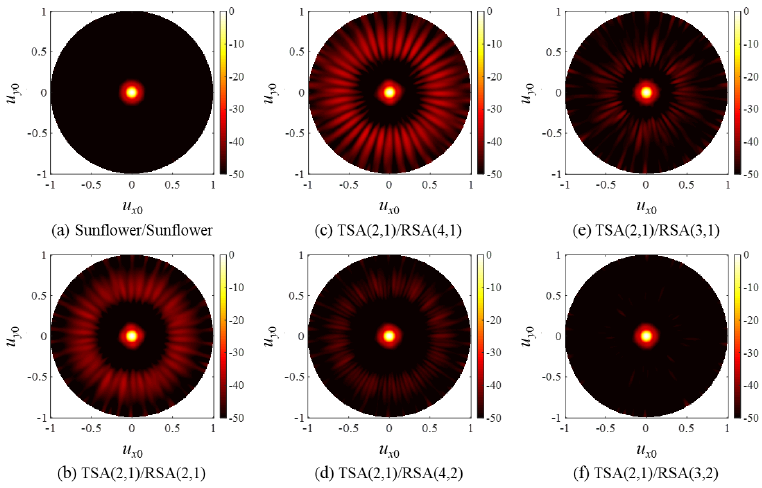
Figure 14. Two-way, PW PSFs of ( a ) the sunflower array pair and ( b – f ) the SSA